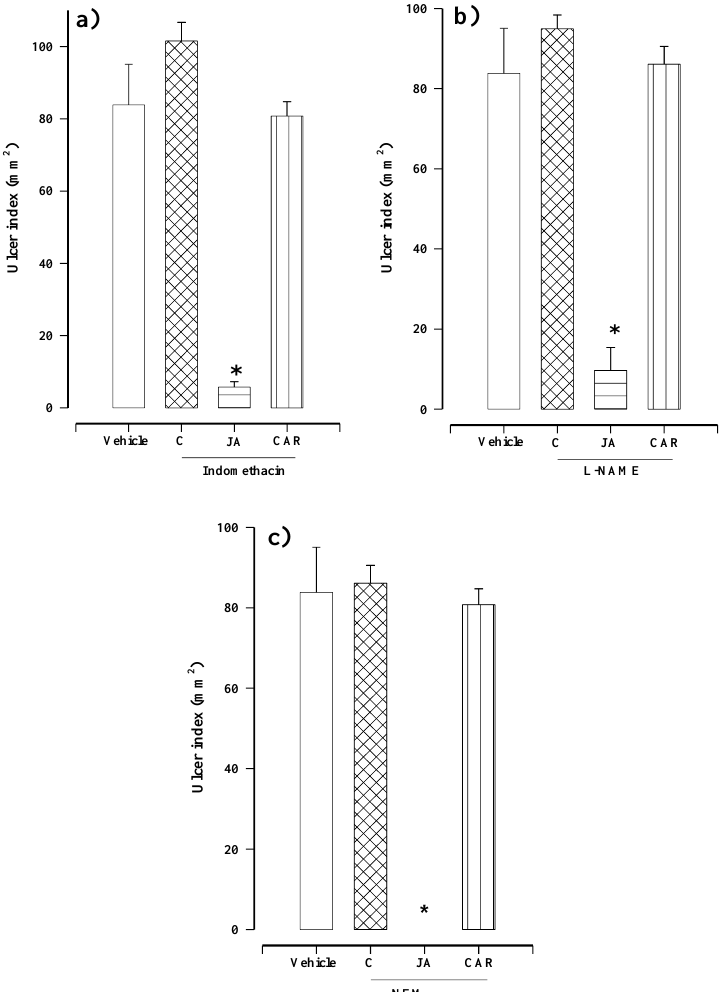
Figure 4. Gastroprotective effect of juanislamin (JA, at 10 mg/kg) and carbenoxolone (CAR, at 100 mg/kg) in rats receiving one of three pretreatments: ( a ) indomethacin (10 mg/kg), ( b ) NG-Nitro- L -arginine methyl ester hydrochloride ( L -NAME, 70 mg/kg) or ( c ) N -Ethylmaleimide (NEM, 10 mg/kg). Comparisons were made to the negative control (vehicle + ethanol). C = different inhibitors plus ethanol. Bars represent the mean ± SEM ( n = 7). * p ≤ 0.05, Kruskal – Wallis